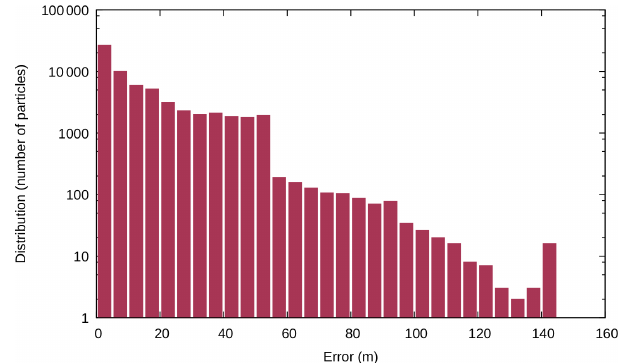
Figure 6. Error logarithmic distribution for the first experiment (iso- viscosity) on the diapiric growth